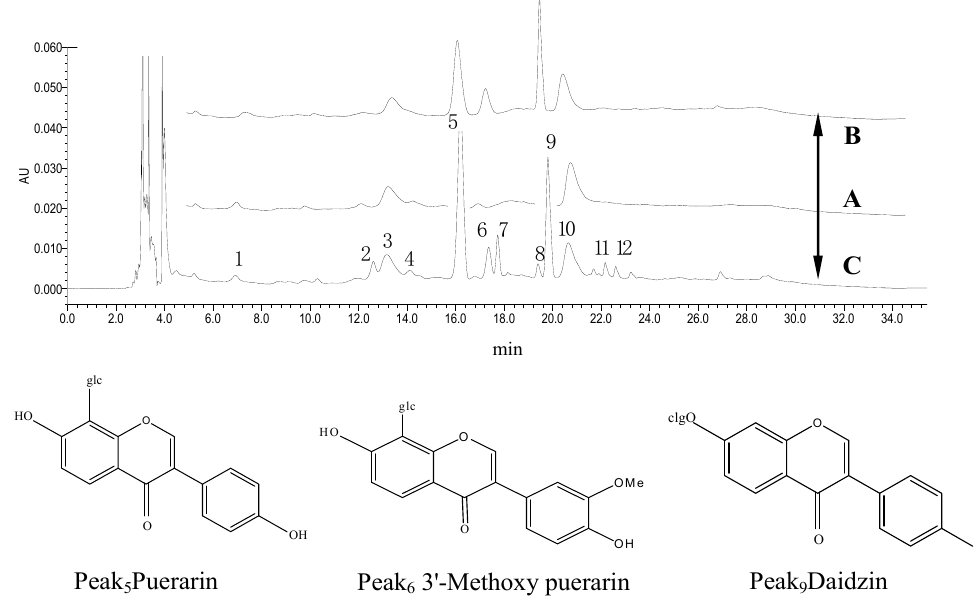
Figure 5. The HPLC chromatogram of Gegen decoction: ( A ) Blank rabbit plasma sample; ( B ) blank rabbit plasma samples piked with puerarin (10 µg/mL), 3 ′ -methoxypuerarin (3.6 µg/mL) and daidzin (7 µg/mL); ( C ) rabbit plasma sample at 35 min after their stomachs were perfused with 0.82 mg/kg G-2 solution. The chromatographic peaks were identical between standards and sample. The three structures are shown above.